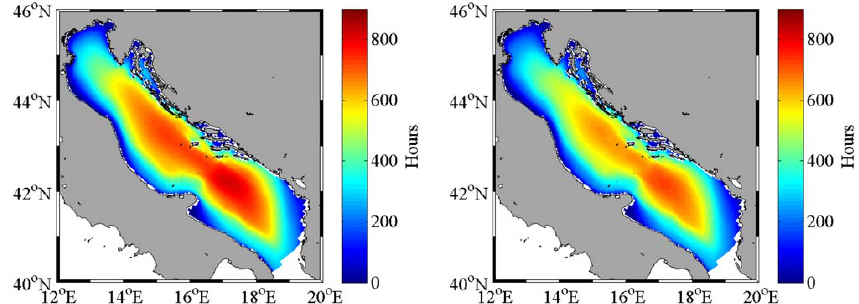
Fig. 10. Yearly average number of hours with H s greater than 2m. Numerical simulations of the present climate (left) and the future scenario (right) are shown.